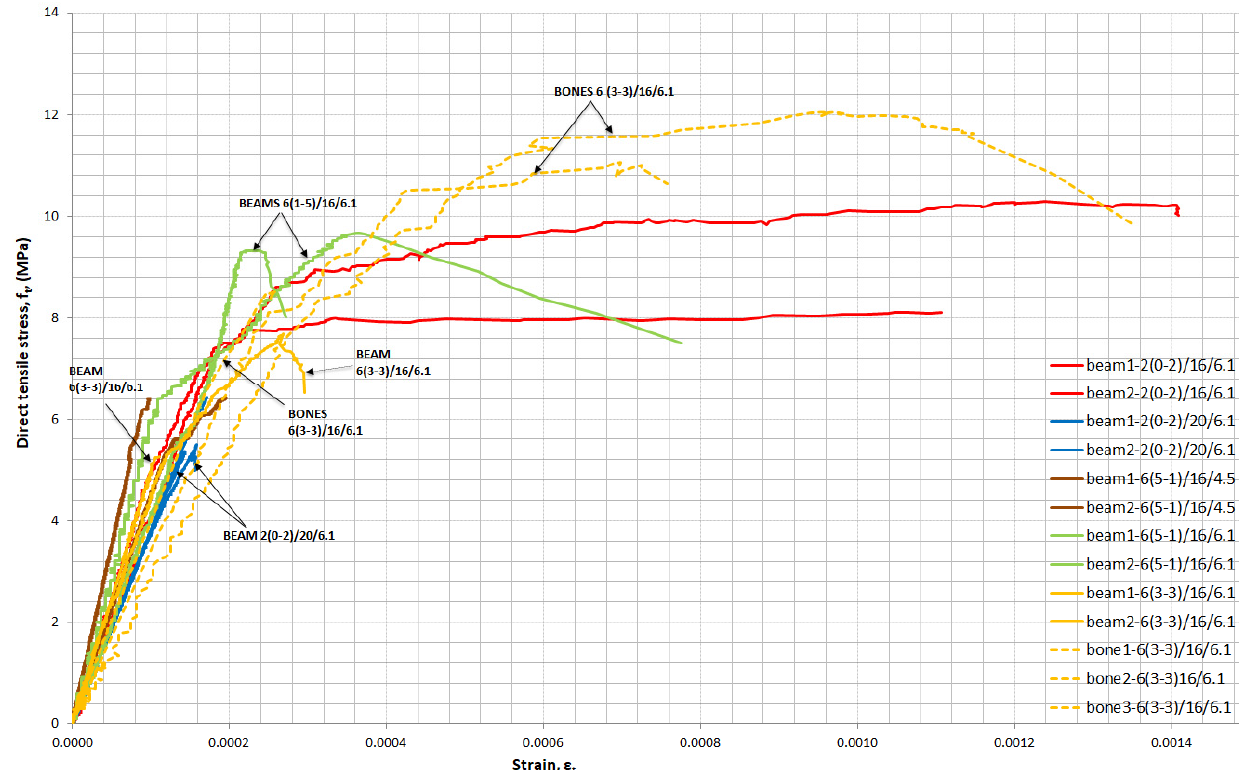
Figure 13. Stress–strain curves in direct tension—the influence of the fibre and shape of the specimens.